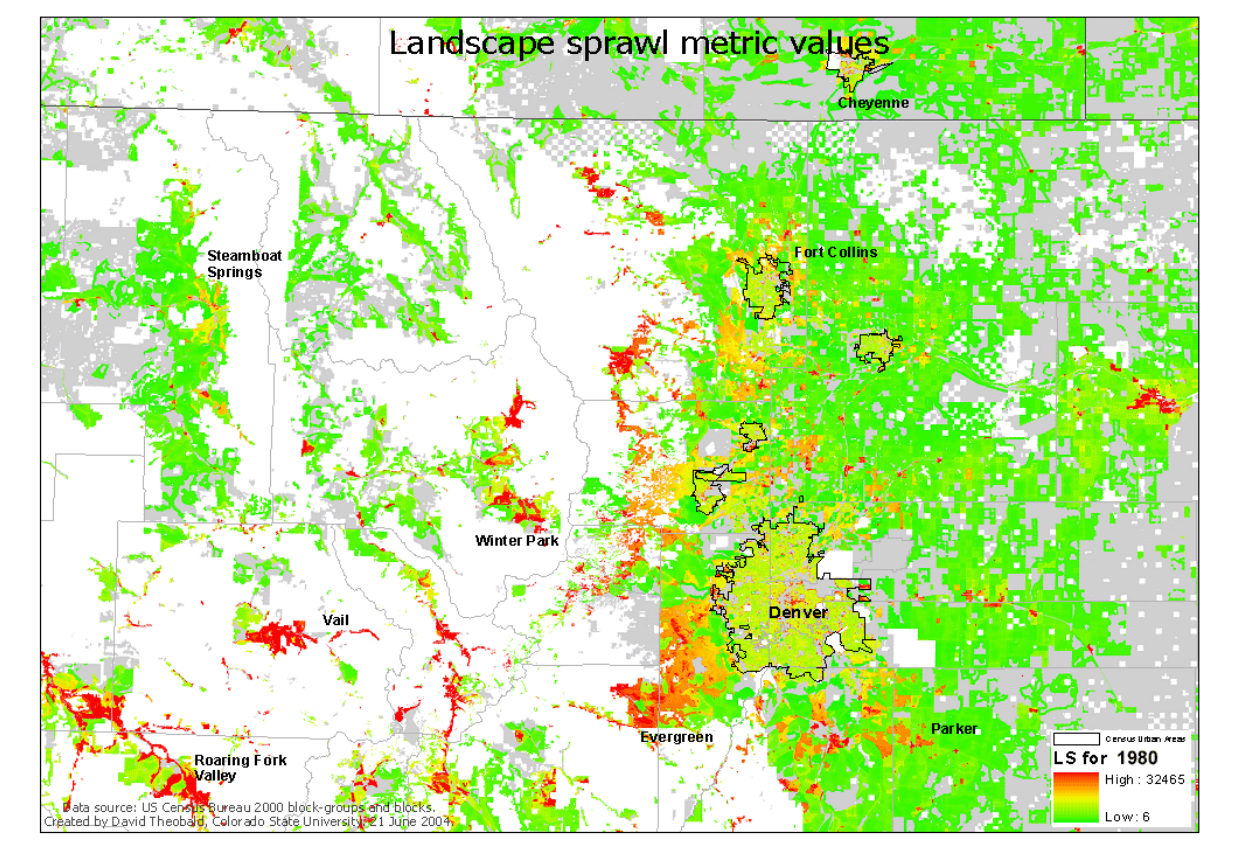
Fig. 17. An animation of the Landscape Sprawl (LS) metric values for northern Colorado, USA for 1980, 2000, and 2020. Higher values (red) indicate more sprawl or greater effect on the landscape. Private rural lands with no housing density are shown in gray, and public/protected lands are shown in white. Note that the LS metric is evaluated for all areas, and rural sprawl can be seen to extend beyond the boundaries of the 2000 Census Urban Areas (black outline). Development can be seen to expand into outlying areas at a more rapid pace than the housing density maps depict. For example, the region to the south and southeast of Denver (near the City of Parker and Douglas County) can be seen to expand rapidly from 1980 to 2000, and is forecast to expand yet again by 2020. Because a key component of the LS metric is distance from urban core, and urban core areas emerge over time, there are some significant phase changes or discontinuities in the LS values. For example, in the region around Evergreen located southwest of Denver, LS values increase rapidly from 1980 to 2000. By 2020, apparently enough land has been converted to urban density that a new urban core area will be established. This complex phase transition is a powerful, but as yet not well understood aspect of exurban land